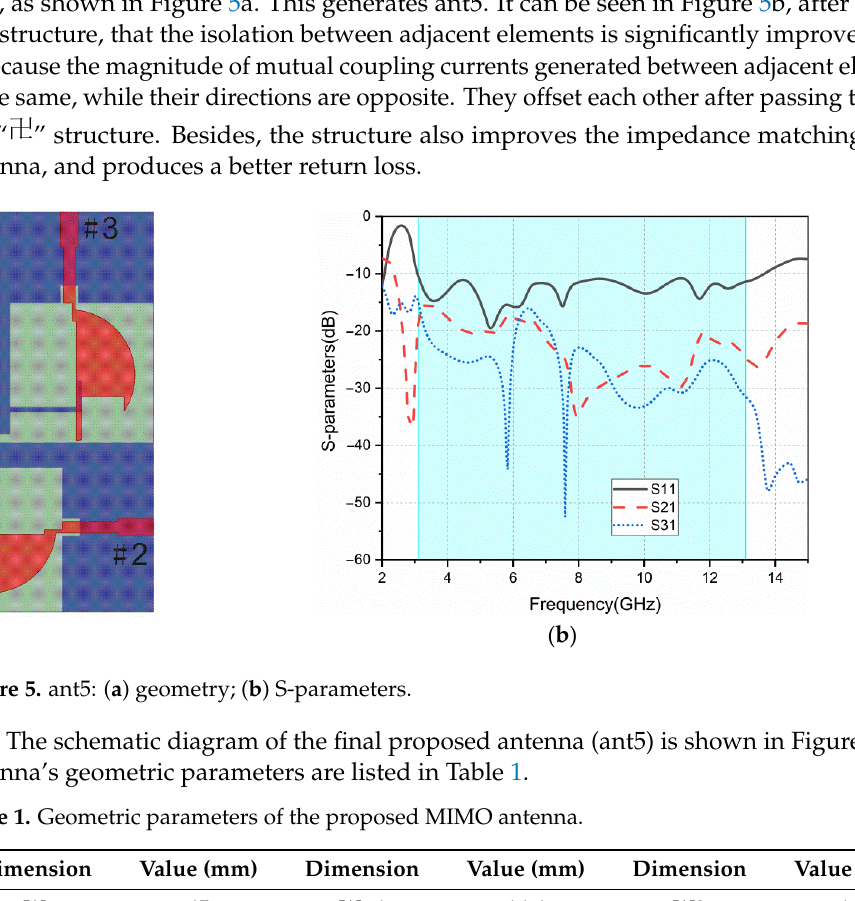
Figure 4. ant4: ( a ) geometry; ( b ) S-parameters.